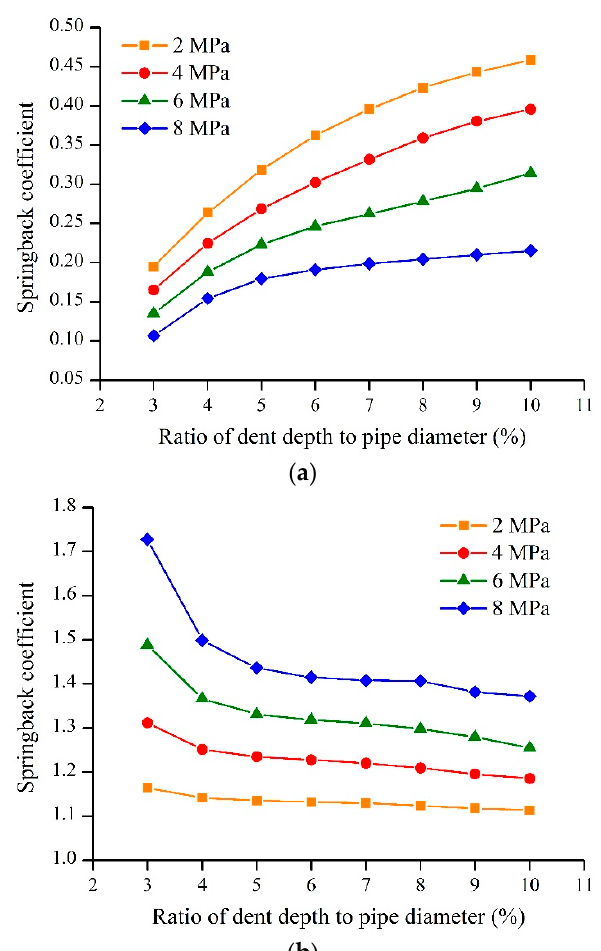
Figure 7. Dent depth and springback coefficient with variation of the internal pressures during denting: ( a ) pressurization; ( b ) de-pressurization.